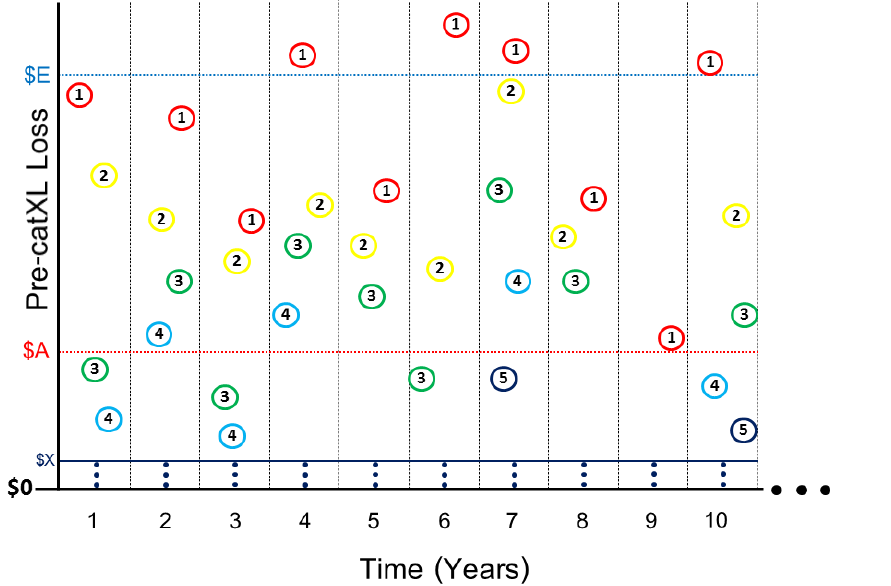
Figure 1. A depiction of a timeline simulation for a given combination of frequency and severity. Each simulation period is one-year in length (x-axis). The y-axis is the primary insurer portfolio loss in $, before the application of any reinsurance. The annual maximum loss events are depicted by the 1’s with red circles. Second annual maximum losses are indicated by the 2’s with yellow circles and so on. Event losses that are less than or equal to $X < $A have values in the closed interval from $0 to $X. The dashed red and blue lines indicated by the $A and $E values correspond to the attachment and exhaustion point of a catXL reinsurance contract that will be applied in what